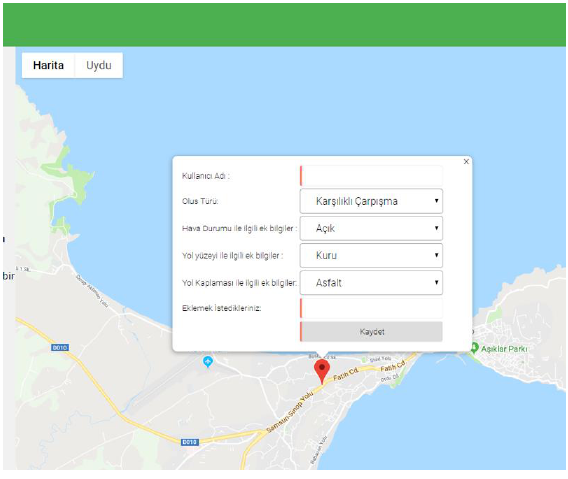
Figure 3. Data entry screen